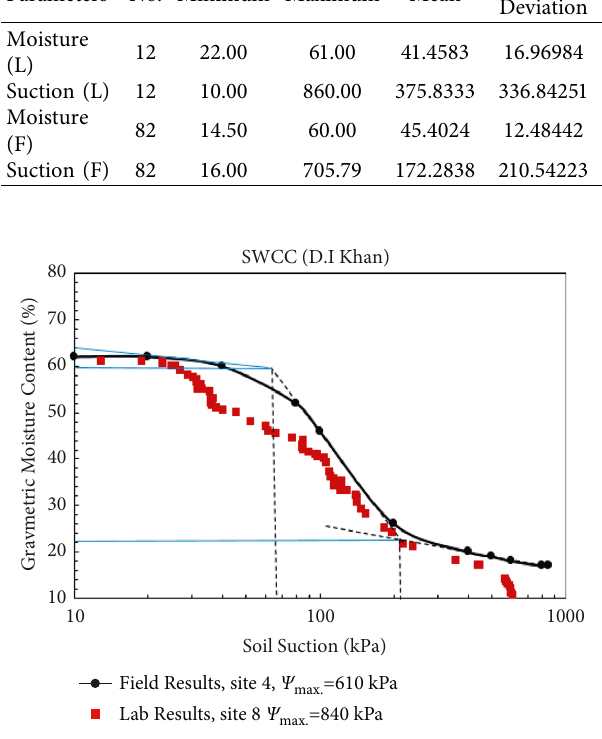
Figure 8: Comparison of field and lab results of the SWCC of Kohat’s expansive